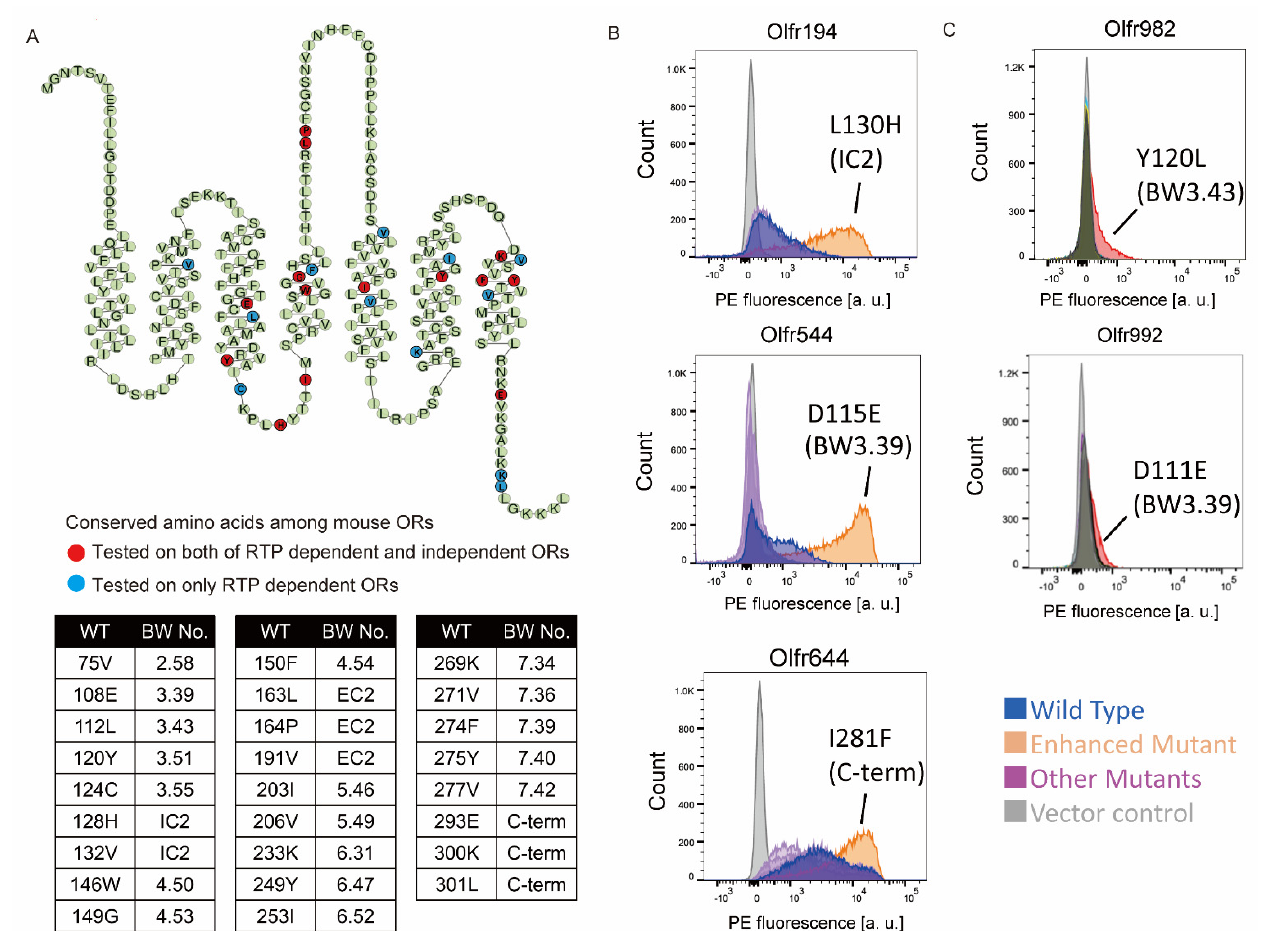
Figure 1. Identification of mutation residues enhancing OR expression. ( A ) Snake plot showing the consensus sequence of mouse ORs. Circle: Amino acid site that constructed the mutant. Red: tested on both of RTP dependent and independent ORs, Blue: tested on RTP dependent ORs only. The table shows the mutation sites and BW (Ballesteros-Weinstein) number [20] tested in this study. ( B , C ) The cell-surface expression of the RTP independent OR (Olfr194, Olfr544 and Olfr644) and RTP dependent ORs (Olfr982 and Olfr992), respectively. Each mutant was transfected into HEK293T cells, and the cell surface expression level was measured. X-axis: PE fluorescence, Y-axis: cell number.